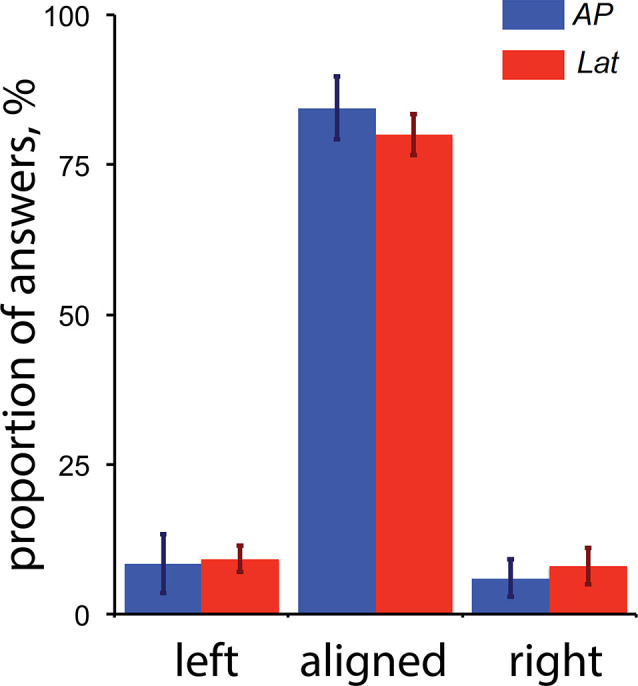
Perceptual reports during the control experiment for vergence (n = 5). The proportion of “left,” “aligned” and “right” answers are provided for both the antero-posterior (AP) and lateral (Lat) conditions. The “left” and “right” reports respectively correspond to convergence and divergence eye movements (see details in the text). The error bars give the standard errors.